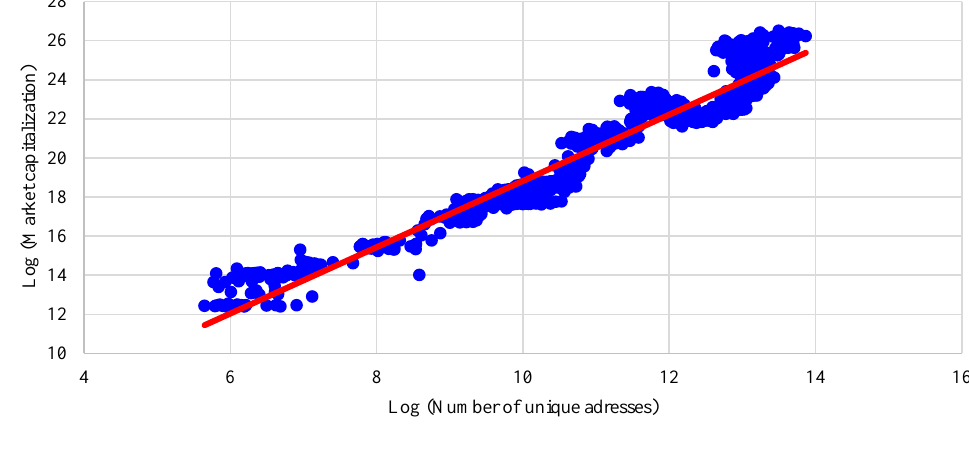
The estimation results of Equation (5) are shown in the Table 4.